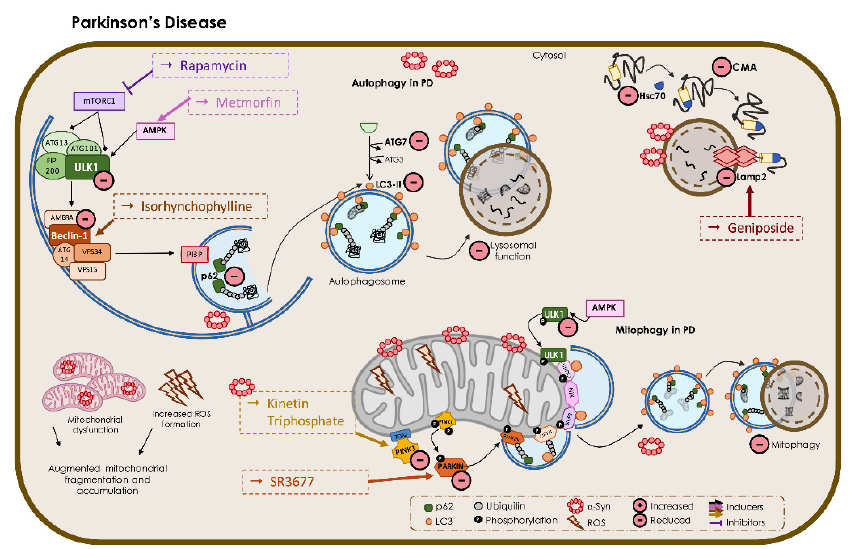
Figure 5. Overview of altered regulation of autophagy and mitophagy mechanisms in PD—role of protective compounds. Autophagy activity is altered in PD. The mTORC1 inhibitor and the AMPK inducer were shown to be protective in PD (referred to in purple and pink dashed boxes, respectively). Concordantly, the Beclin-1 inducer agent (referred to in the brown dashed box) was shown to have positive effects in PD models favoring autophagy. Several PD models showed reduced CMA function, whereas the LAMP2A inducer (red dashed box), was shown to significantly improve CMA function and PD features. Furthermore, augmented dysfunctional mitochondria and reduced mitophagy were observed in several PD models. Concordantly, PINK1 and PARKIN were shown to be diminished in PD, whereas inducer agents (referred to in the yellow and orange dashed boxes, respectively) were shown to have positive effects in different PD models, most of them by increasing mitophagy activity.